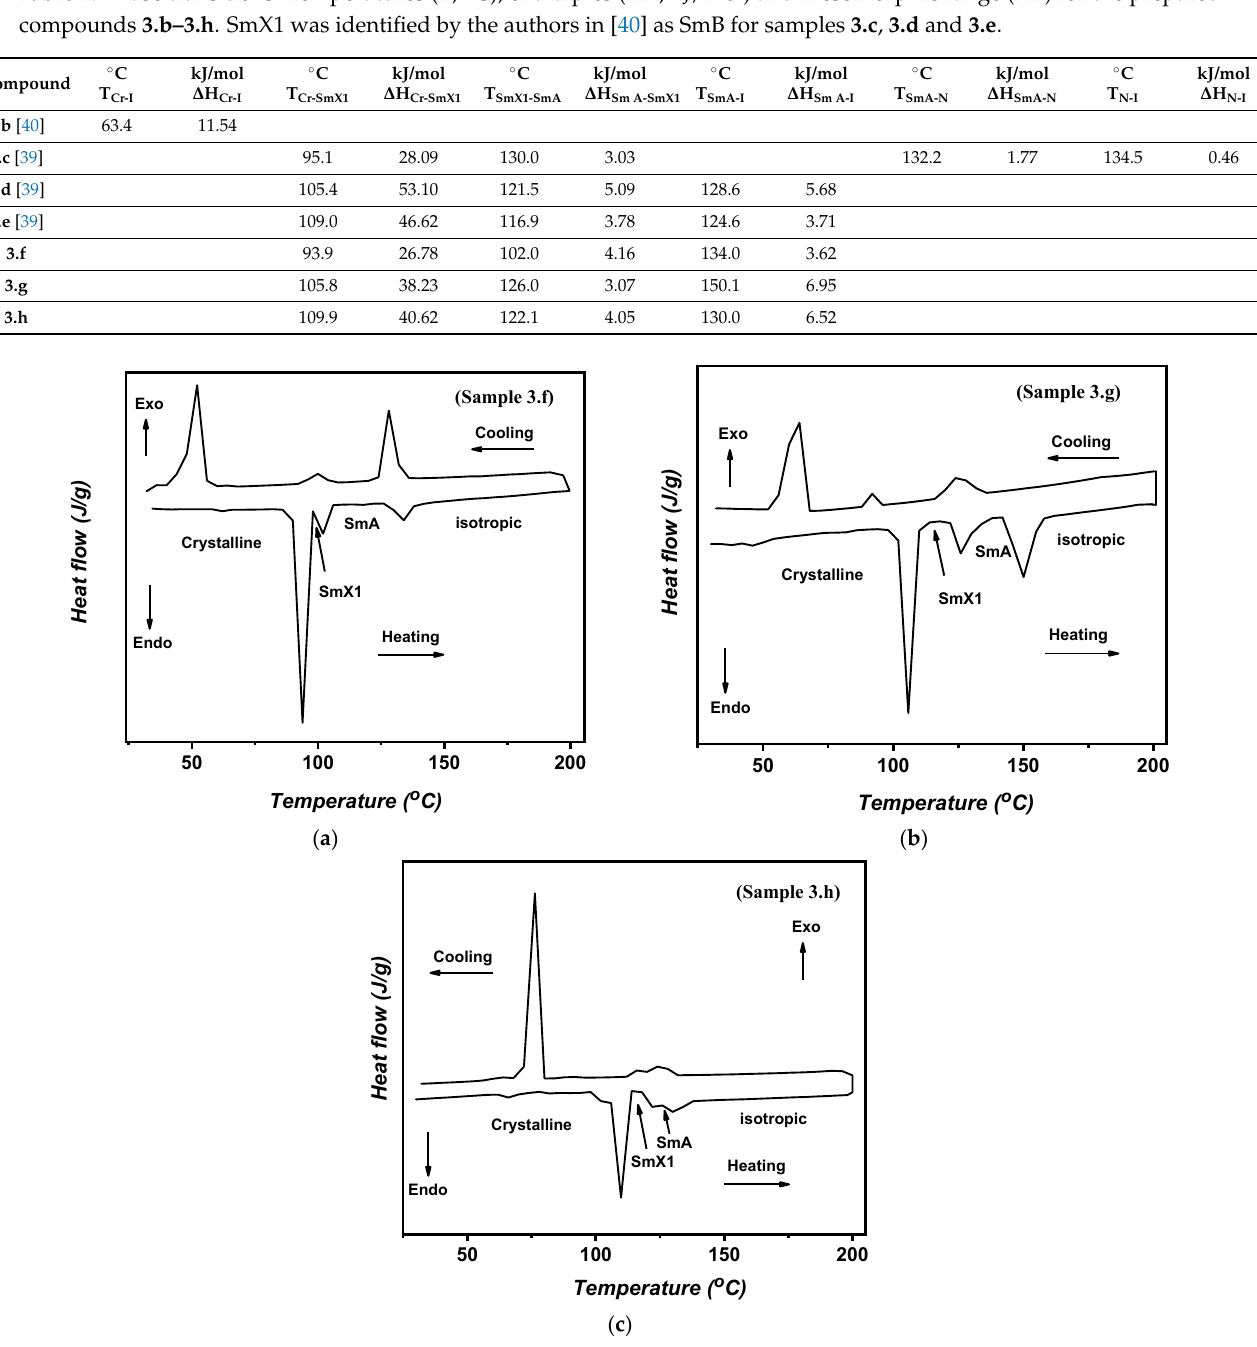
Figure 1. DSC thermograms of compounds 3.f ( a ), 3.g ( b ) and 3.h ( c ) during first heating and cooling cycles (10 ◦ C min − 1